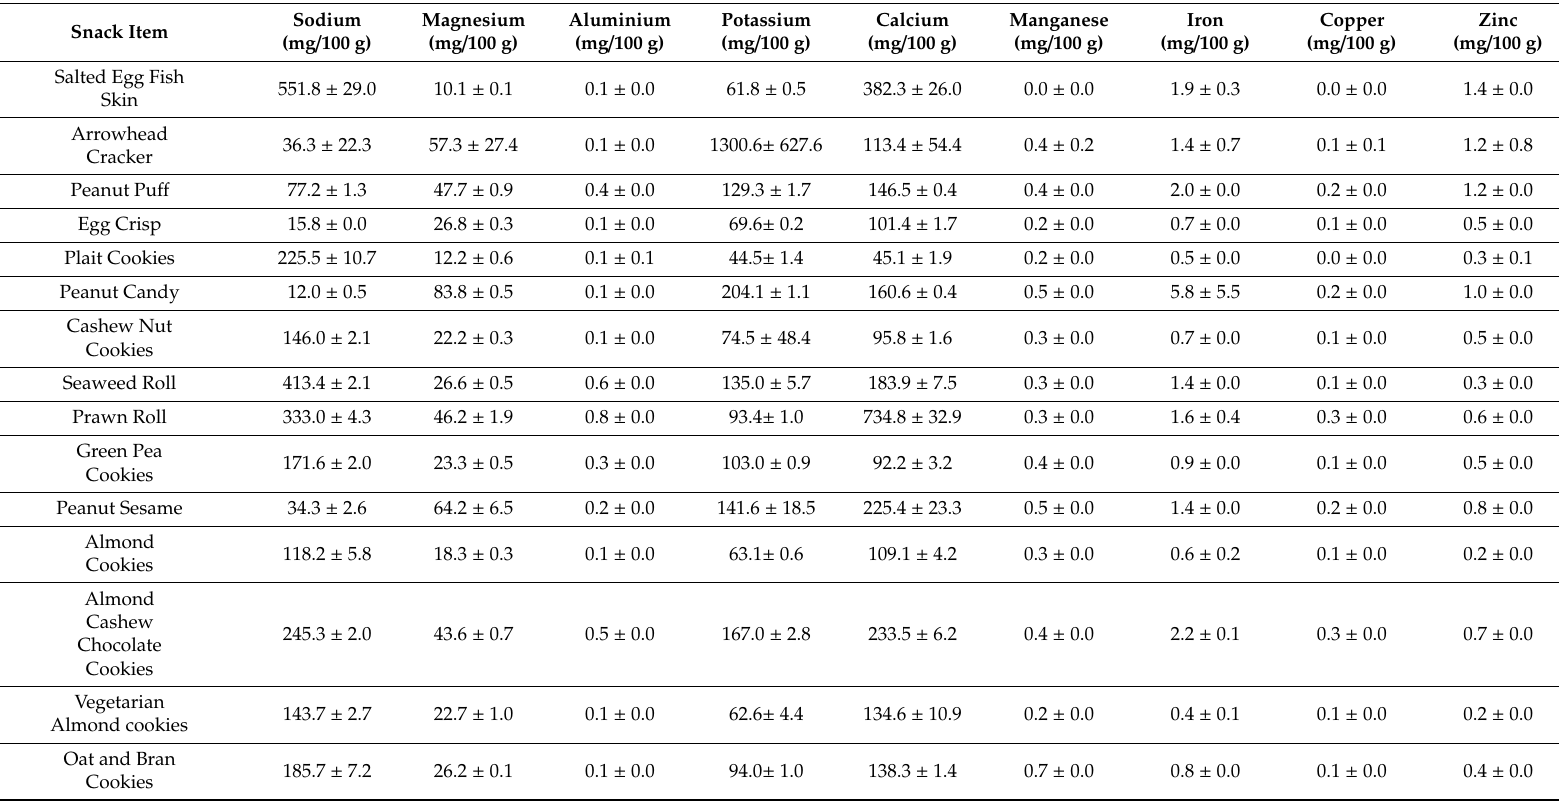
Table 3. Mineral contents of the commonly consumed CNY snacks. Values are expressed as mean ±